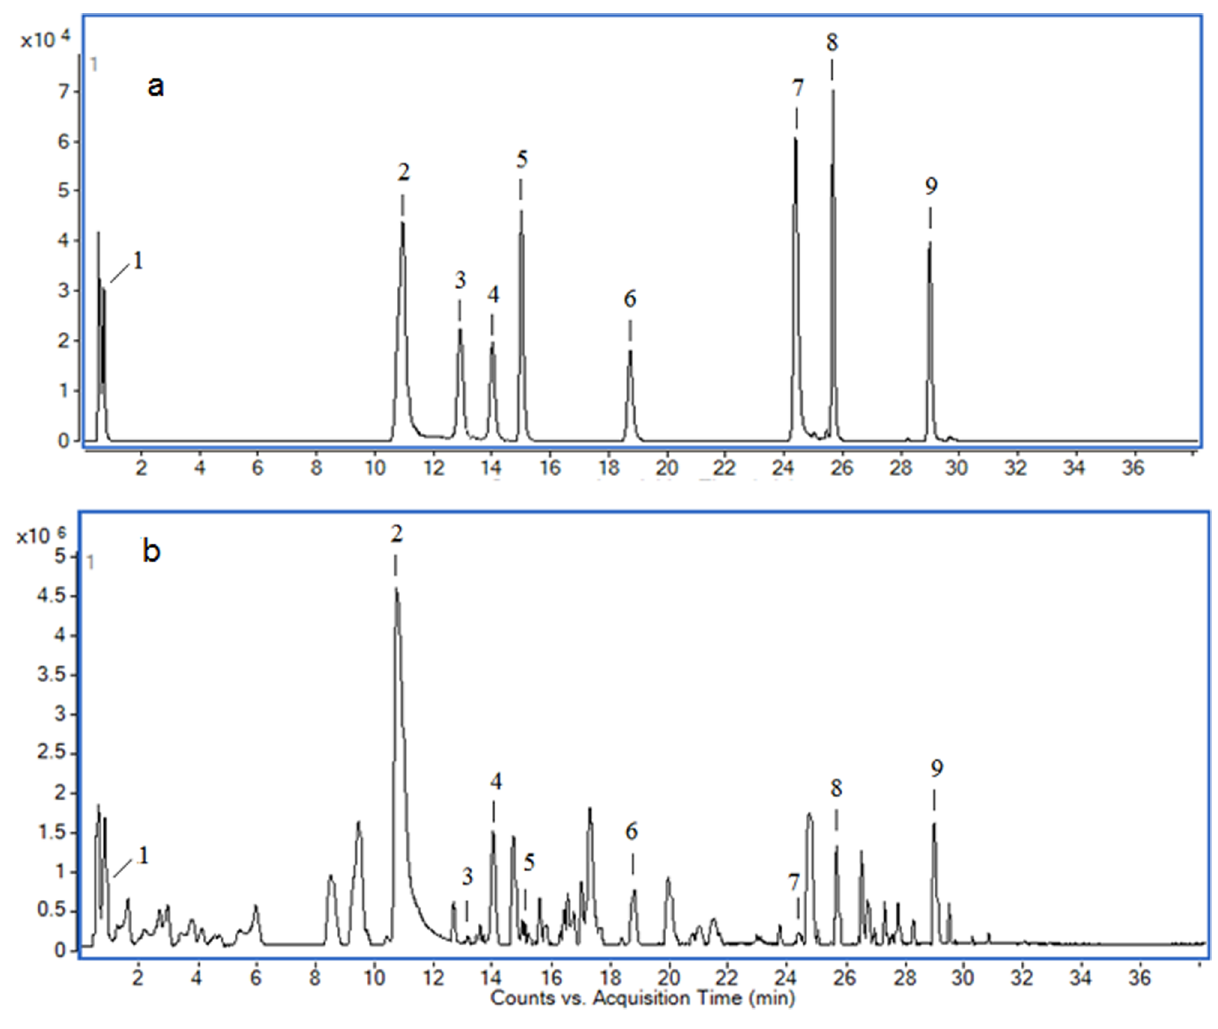
Figure 1. BPC of standards (a) and JP (b).